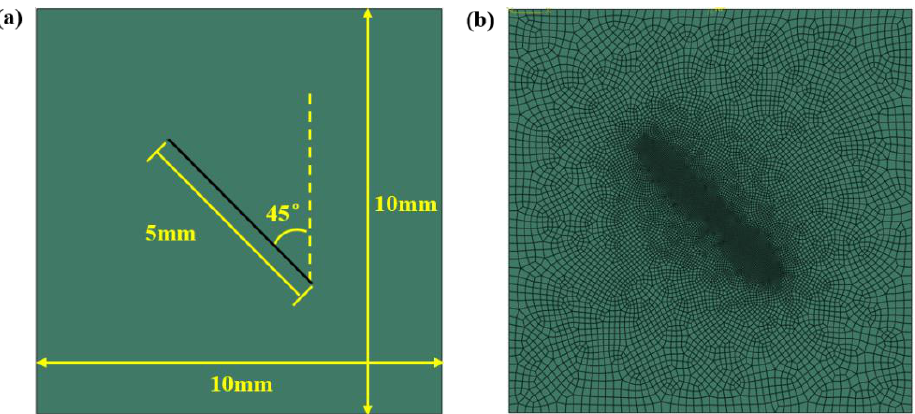
Figure 8. Schematic diagram of the strata model with a crack: ( a ) model dimensions; ( b ) meshing.